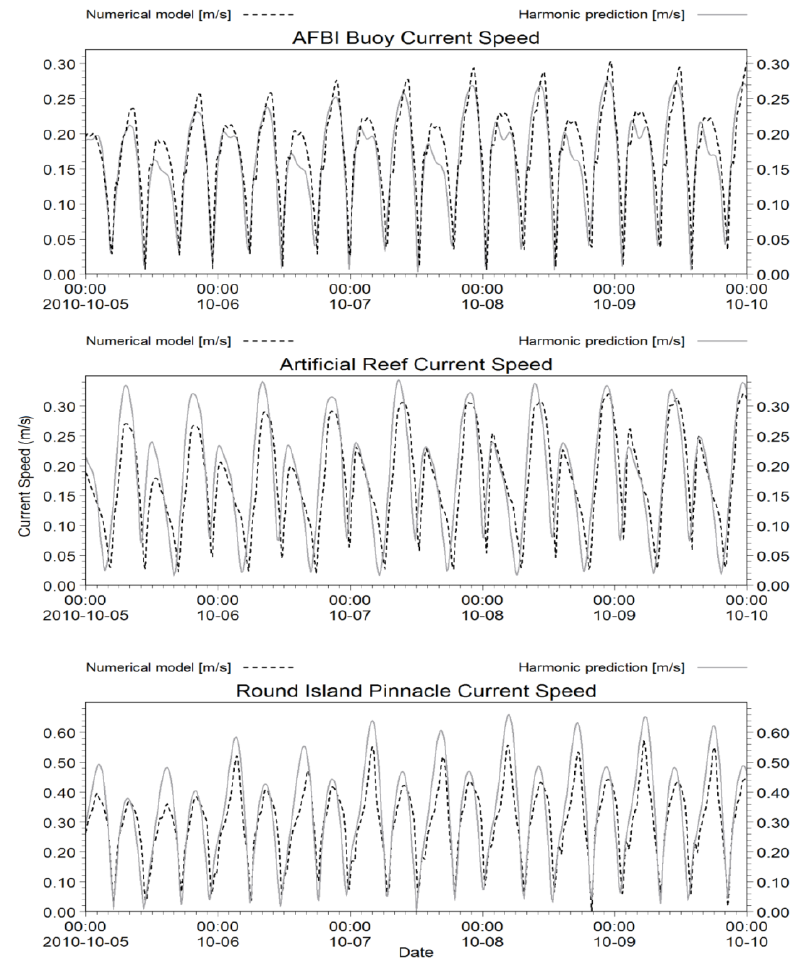
Figure 8. Comparison of current speed between the harmonically predicted and numerical model at: AFBI Buoy, Artificial Reef and Round Island Pinnacle during the period 5–10 October